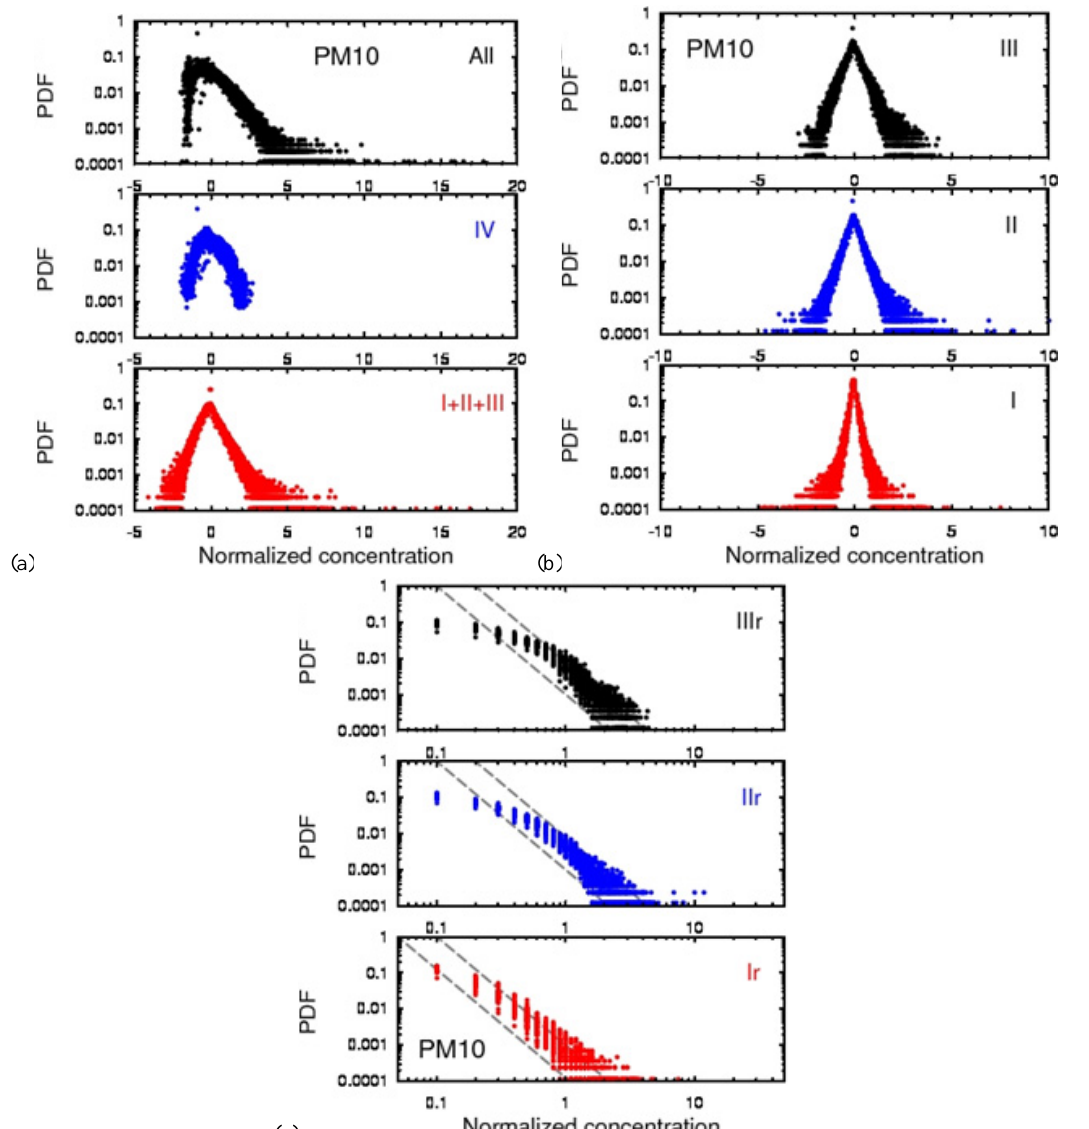
Fig. 14. PDFs for aerosol (PM 10 ) . Panel (a) : the black, blue, and red dots are for the original time series, the reconstructed time series in the frequency bands IV and V, respectively. The bands IV and V include the frequencies lower than and higher than the synoptic peak, respectively. Panel (b) : the black, blue, and red dots are for reconstructed time series in the frequency bands III, II and I, respectively. The sum of the frequencies in regions I, II and III is the same as those in the region V. Panel (c) : as in panel (b) except only the positive sides of the PDFs plotted in the log-log scale. The grey dash line has an exponent of − 3. In the panels (a) and (b) , the plots are in semi-log